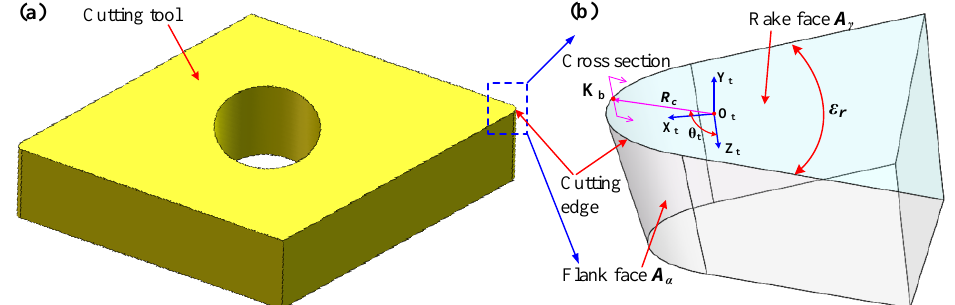
Figure 11. Illustration of the tool geometry model: ( a ) the whole cutting tool; ( b ) the tool geometry model to be established.